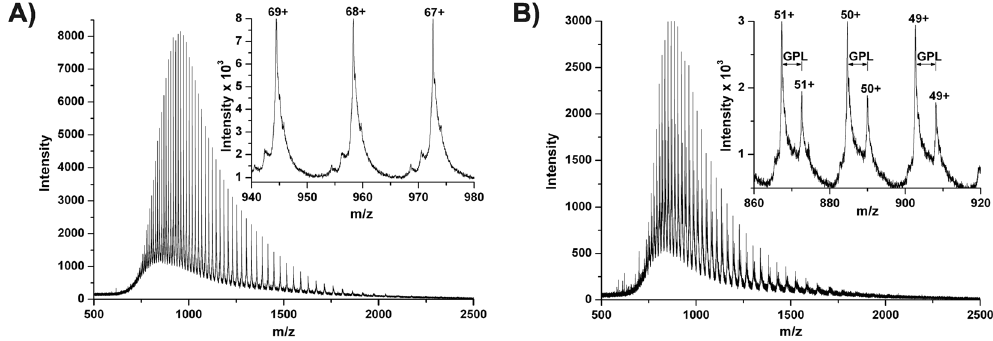
Figure 4. ESI-MS of latent and activated Ab PPO4; ( A ) latent Ab PPO4, ( B ) activated Ab PPO4.